Question: Describe this figure in one sentence.
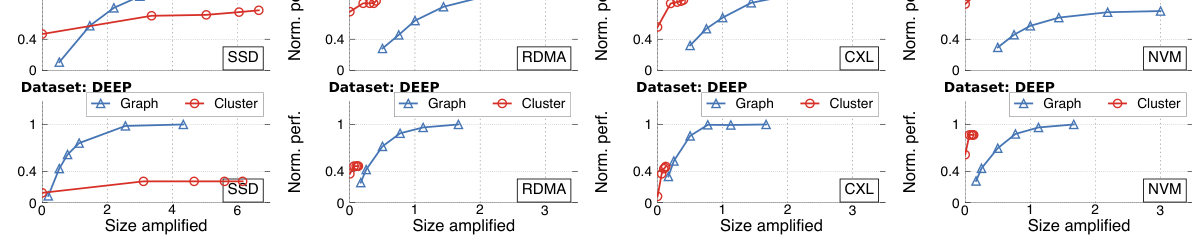
Answer: End-to-end comparison of graph and cluster index performance on (a) SSD, (b) RDMA, (c) CXL, and (d) NVM.